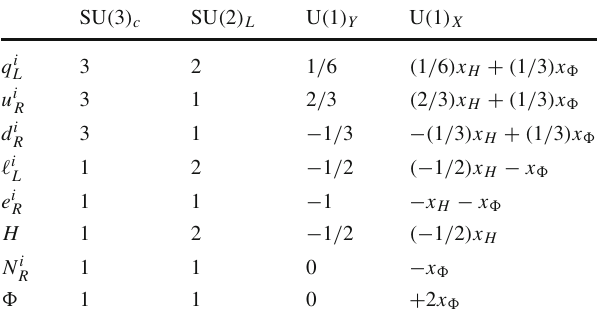
Table 1 Particle content of the U ( 1 ) X model, where i = 1 , 2 , 3 are generationindices.Withoutlossofgenerality,wefix x (cid:5) =